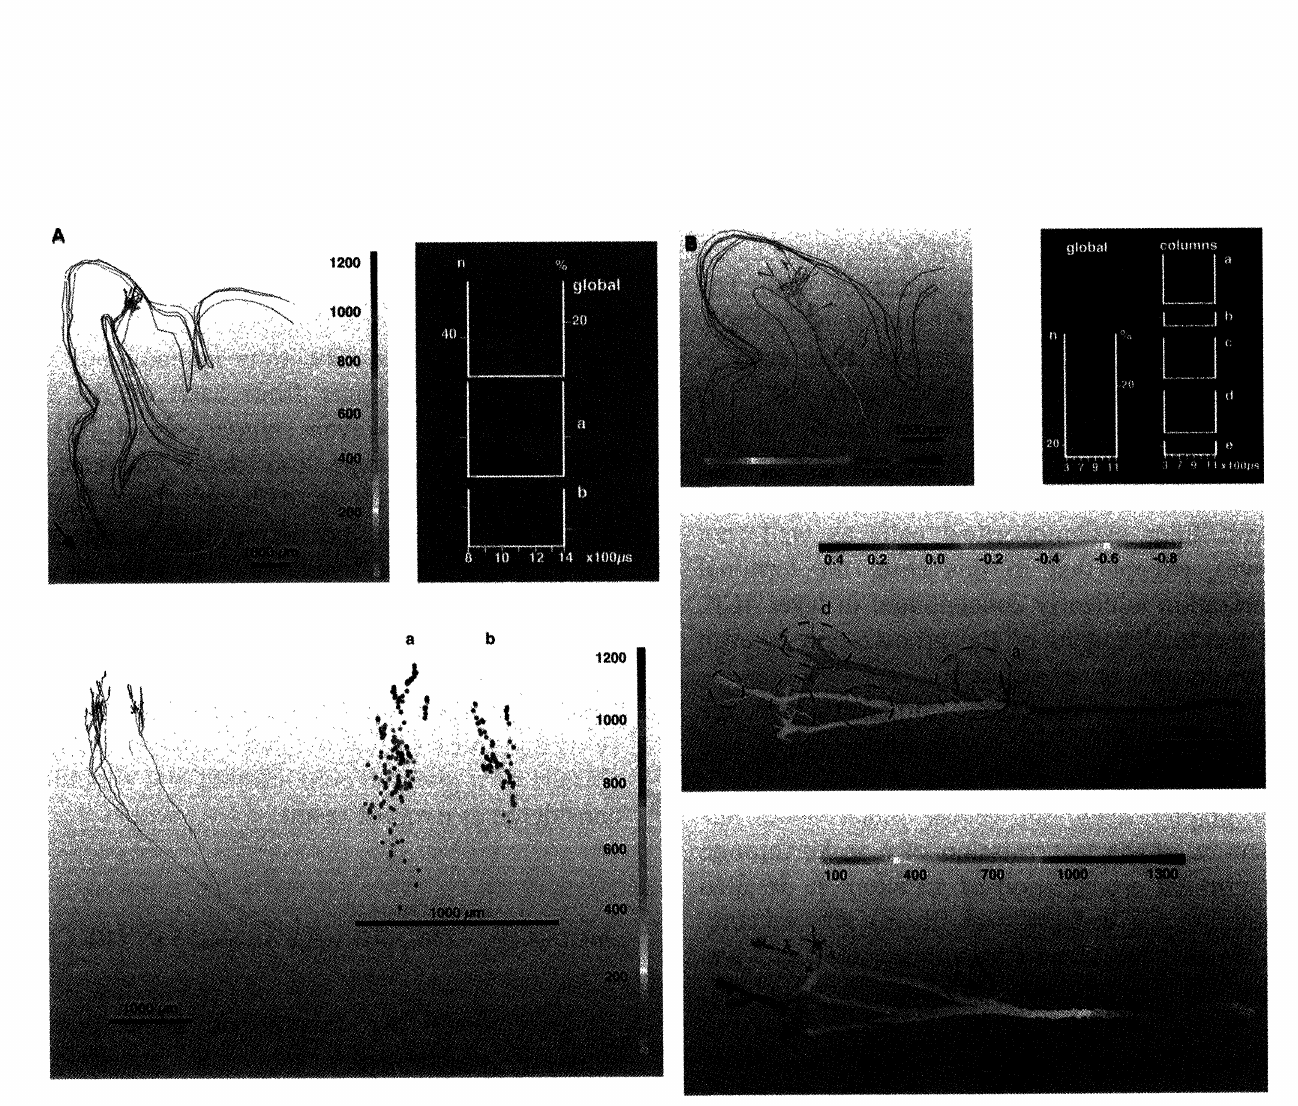
Fig. 6: Two transcallosal fibers, originating near the border between areas 17 and 18 of the visual cortex of a cat and innervating the contraletral homologous area, were anterogradely labeled with biocytin, reconstructed in 3-D from serial sections. Their architecture was fed into a simulation software (Maxsim; see Tettoni et al, 1993) for allowing to study the temporal activation profile of their terminal arborization. The time of activation, counted from the crossing of the interhemispheric boundary, is coded in false colors, according to scales shown (A) This transcallosal fiber has an early split, long before the terminal arborization. The two main branches innervate two distinct clusters located in two distinct microcolumns, about 600 tm apart. All terminals boutons, within or across the two clusters, receive an action potential within a window of time about 400 kts wide. (B) This more complex terminal arborization innervates five distinct clusters, labeled a,b,c,d,e. One branch (in yellow in the topographical map, middle panel) innervates clusters a, b, c, and e; the other branch innervates clusters a and d and then, by a reconvergence, cluster e. All terminal boutons within a cluster receive the action potential within 200 ts or less, and the spread across the clusters does not exceed -300 ps. (After Houzel et al., 1994 and Innocenti et al.,